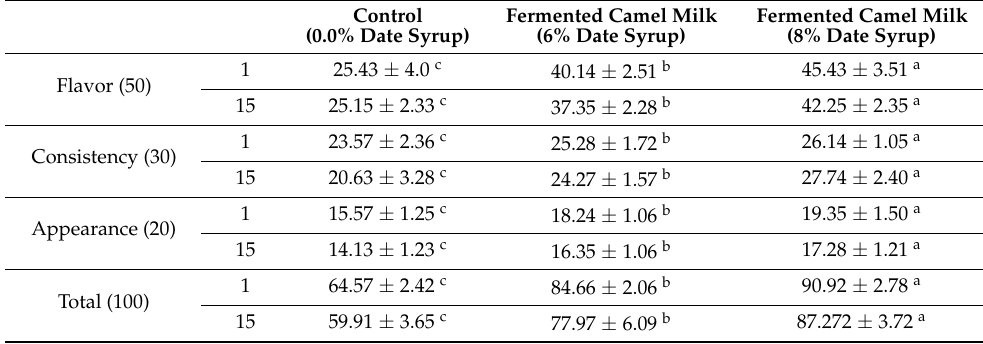
Table 7. Influence of date syrup addition on the sensory evaluation of camel milk yogurt during cooled storage